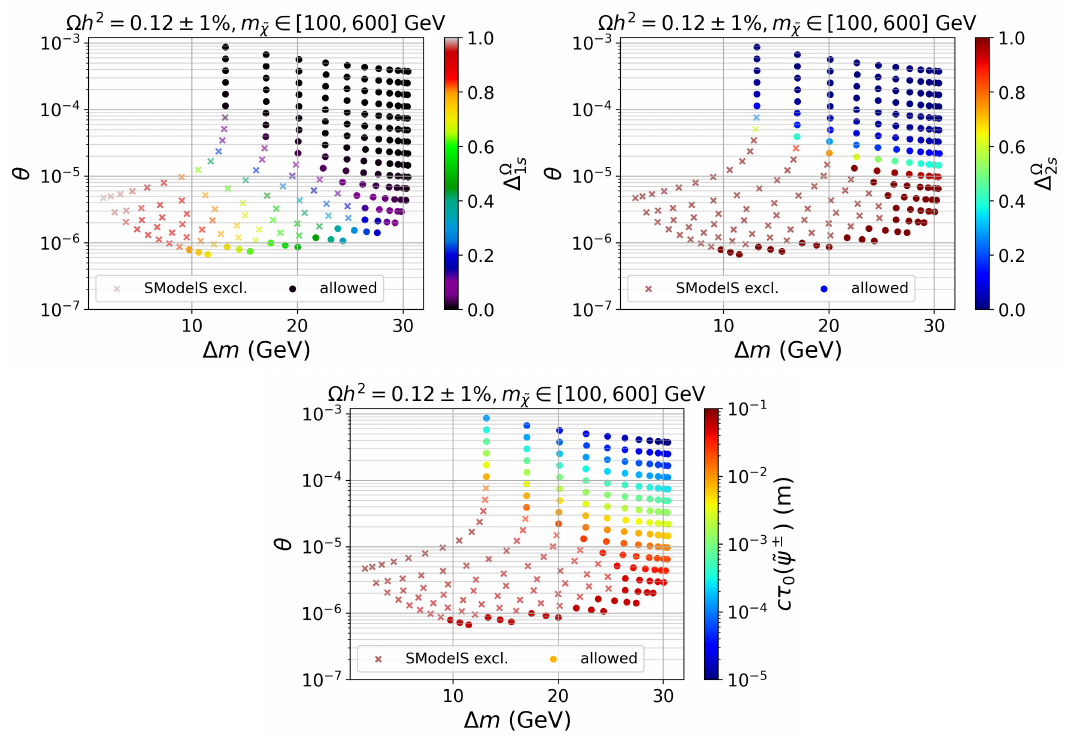
Figure 10: Mixing angle θ versus ∆ m for m χ = 100 − 600 GeV (from left to right in steps of 50 GeV). The colour scales show ∆ Ω (top left), ∆ Ω (top right), and the 1 s 2 s ˜ ψ ± mean decay length, c τ ( ˜ ψ ± ) , in meter (bottom). Points marked as crosses are 0 excluded by SM ODEL S